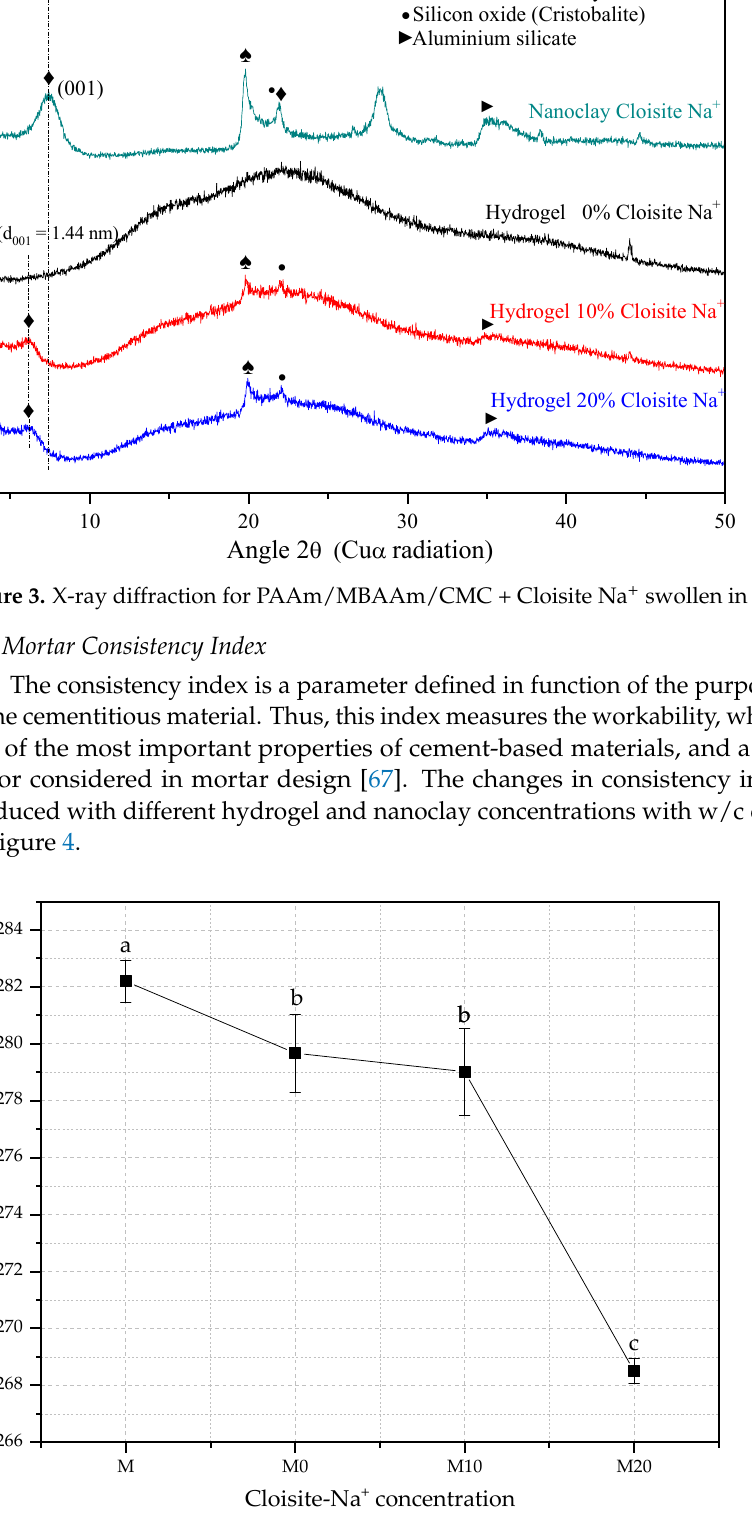
Figure 4. Comparative of the consistency index for mortars with different water/cement ratios different Cloisite-Na + nanoclay hydrogels. Average with their respective standard deviation values, followed by equal letters do not differ statistically from each other, following the Tukey test with a 95% confidence level .